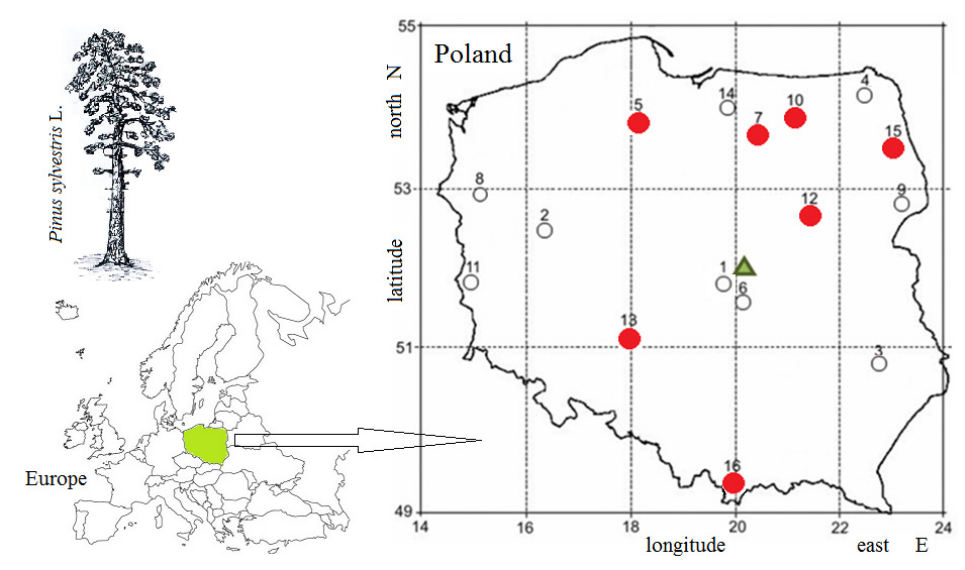
Figure 1. Genetic origin of Scots pine trees (red dots on the map), grown on an experimental plot at the Forest Experimental Station in Rogów (green triangle on the map): 5—Lipowa, in the Tucholskie Forest 130 m a.s.l.; 7—D ł u ż ek, the Napiwodzko–Ramuckie Forest 145 m a.s.l.; 10—